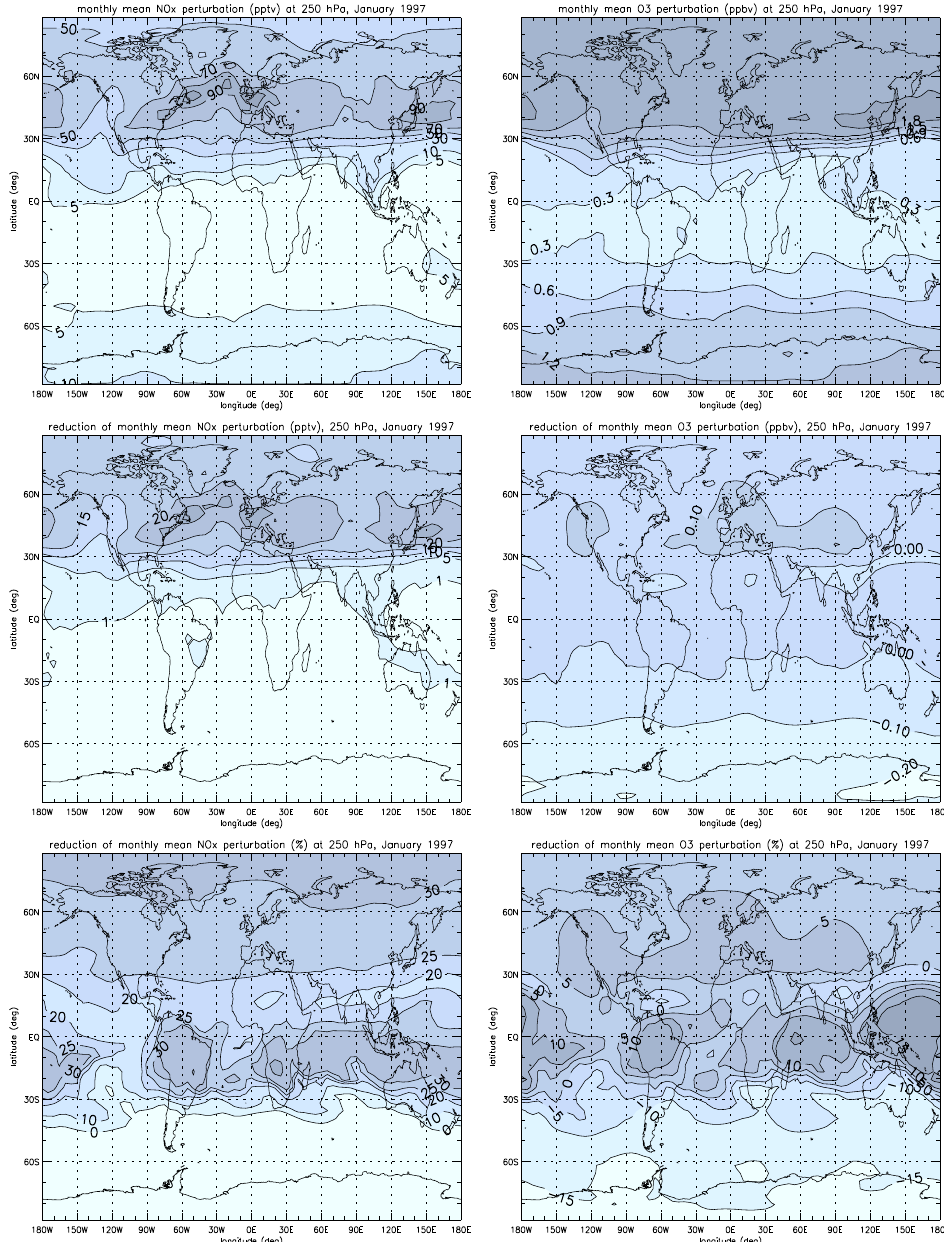
Fig. 19. Impact of aircraft NO x on the monthly mean concentration of NO x and O 3 at 250hPa for January. Top panels, aircraft perturbations with no plume model (run A ); middle panels, perturbations using ECFs (run B ); bottom panels, percentage difference. Positive numbers in the lower four panels indicate a reduction due to the inclusion of aircraft plume emissions (Meijer,